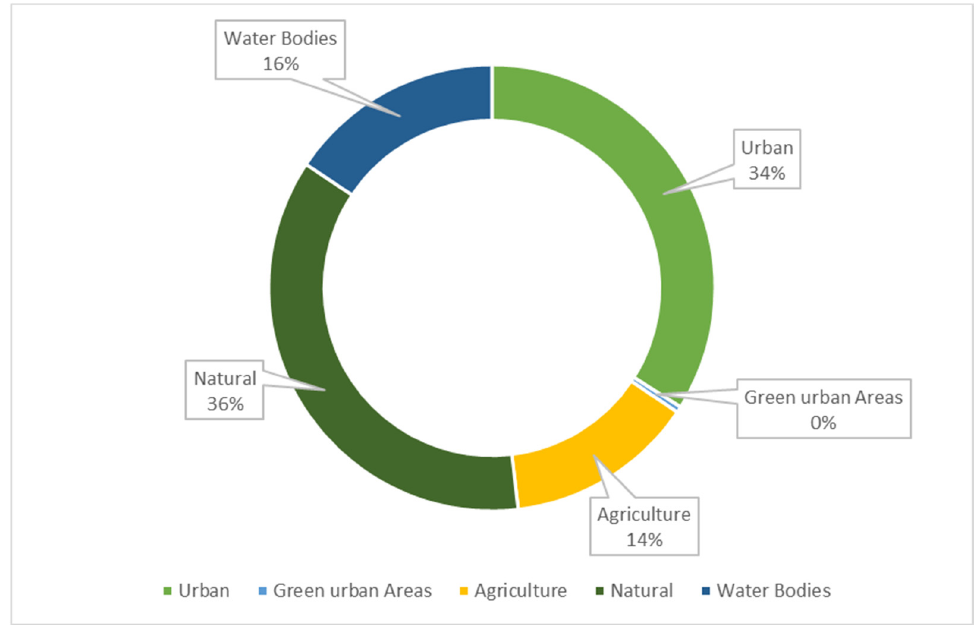
Figure 3. Land Use Land Cover composition in the Area of Interest. (source: author’s